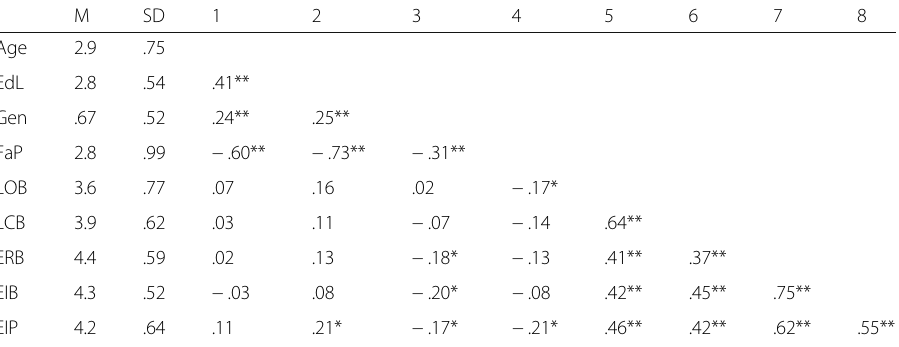
Table 2 Means, standard deviations, and correlations among variables ( N = 147) M